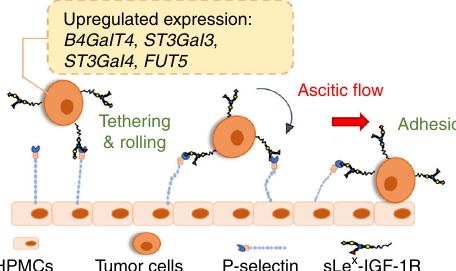
Fig. 7 Schematic of sLe x -P-selectin binding in